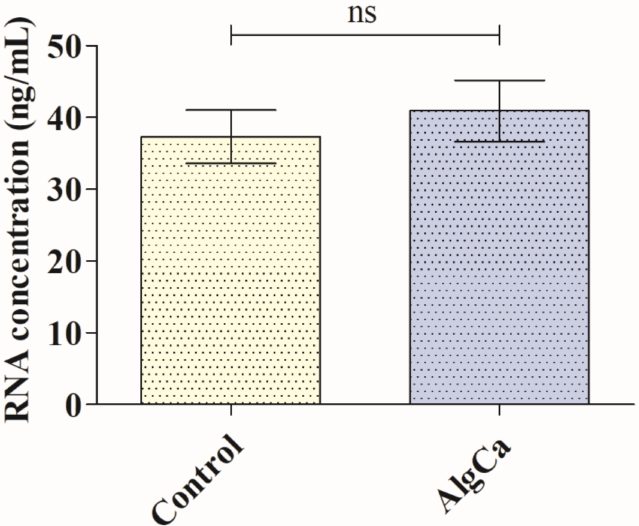
Figure 4. Bacteriophage phi 6 RNA extraction and quantification: Bacteriophage RNA concentration before (control) and after being in contact with the calcium alginate (AlgCa) films for 30 min expressed in ng/ µ L. Student’s t -test (ns, not significant).